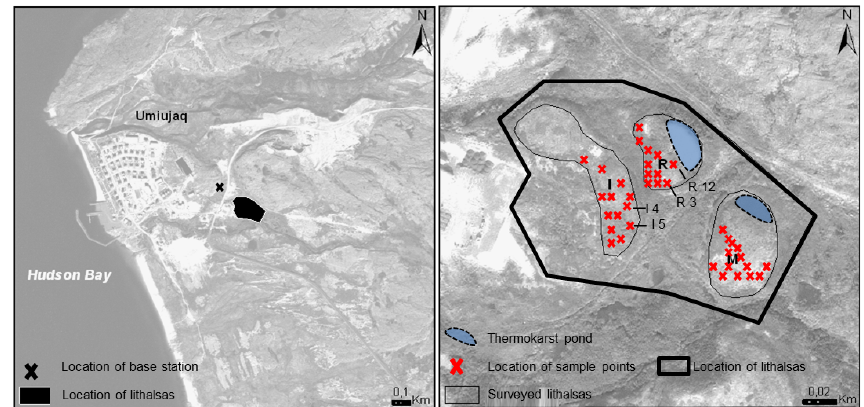
Figure 3. Left: location of the surveyed lithalsas and the base station, southeast of Umiujaq (background: GeoEye image from 25 Septem- ber 2009). Right: enlargement showing the three lithalsas (I, R and M) and the locations of the individual measurement points. The identified measurement points (R3, R12, I4, I5) are specifically discussed in Sect.